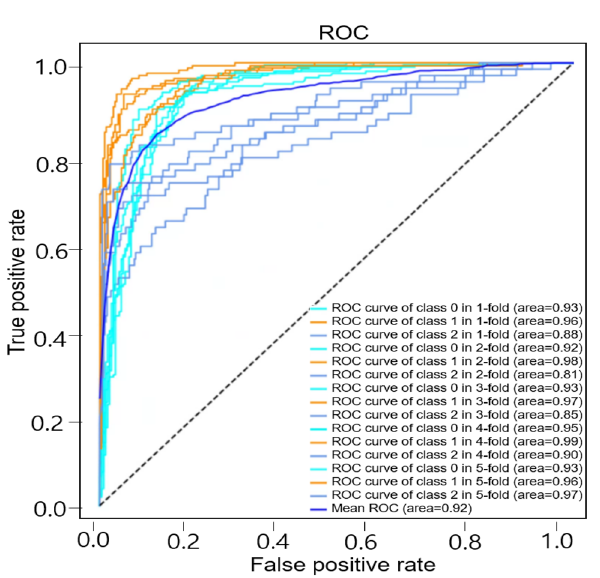
Figure 3. ROC of the model for classifying abnormal lung sounds into crackles, wheezes, and rhonchi. Each plot illustrates the ROC of the algorithm on the independent testing set for crackles, wheezes, and rhonchi with the mean AUC of